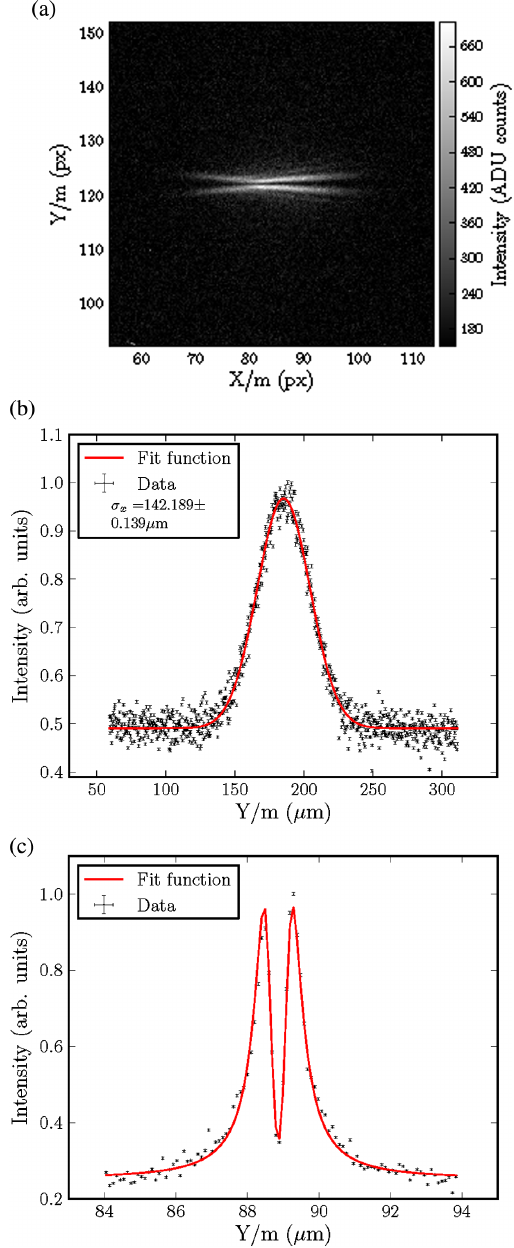
FIG. 9. Experimental setup of the high-resolution OTR imaging system at ATF2/KEK.